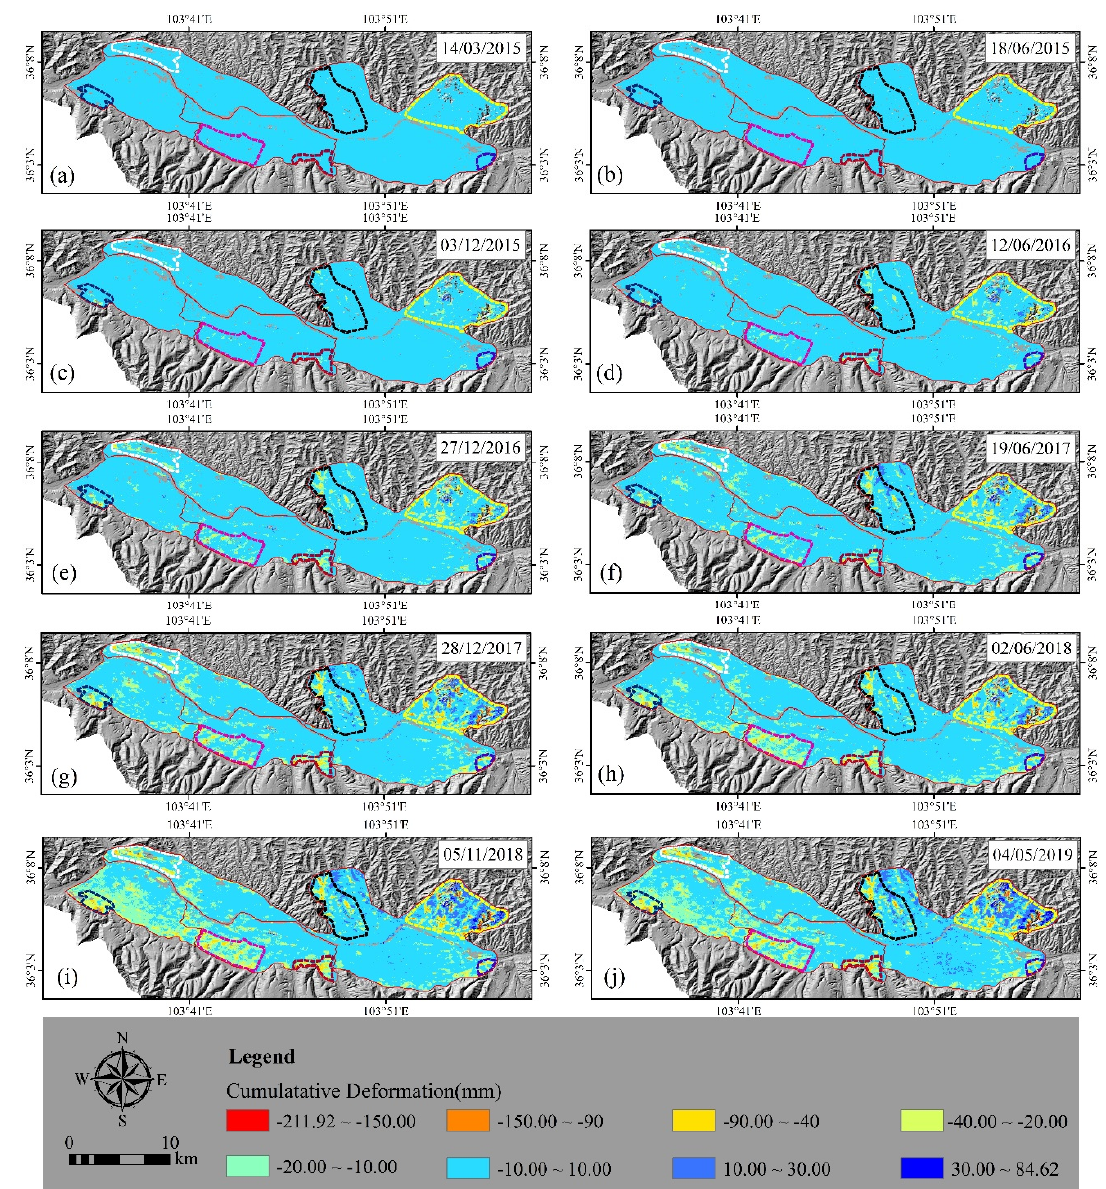
Figure 7. Time-series land surface deformation map.